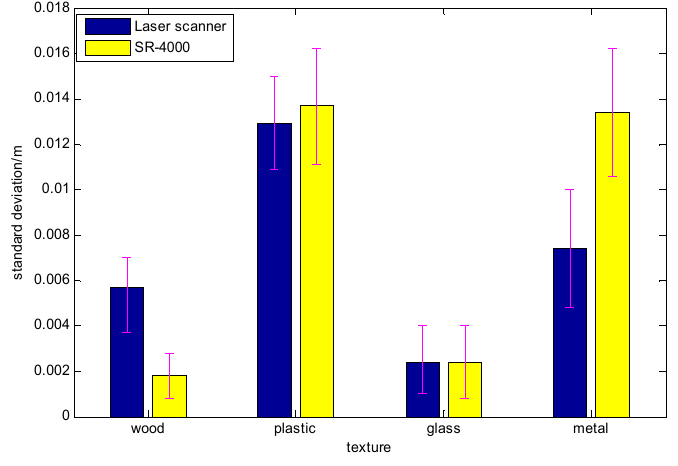
Figure 7. Depth data of two sensors.